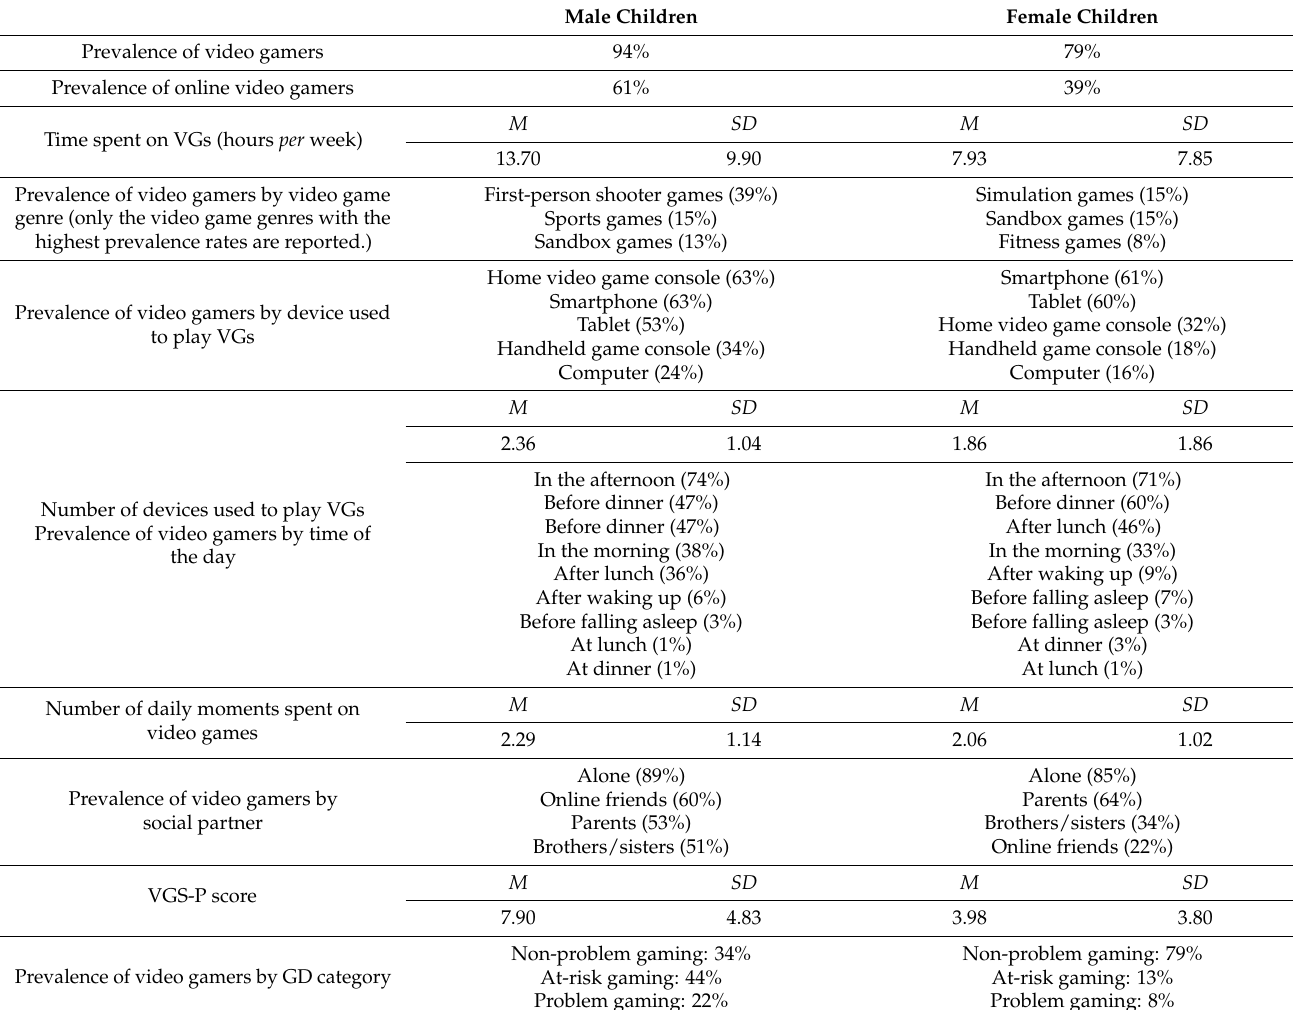
Table 1. Gaming habits of children based on